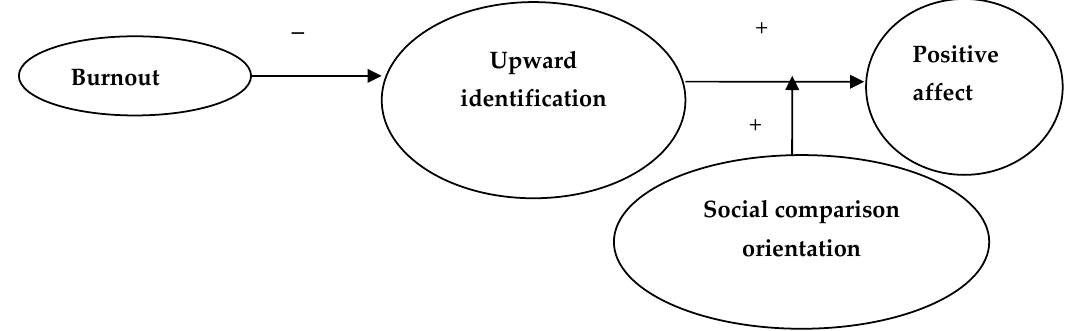
Figure 6. Predicting positive affect following upward social comparison [13].